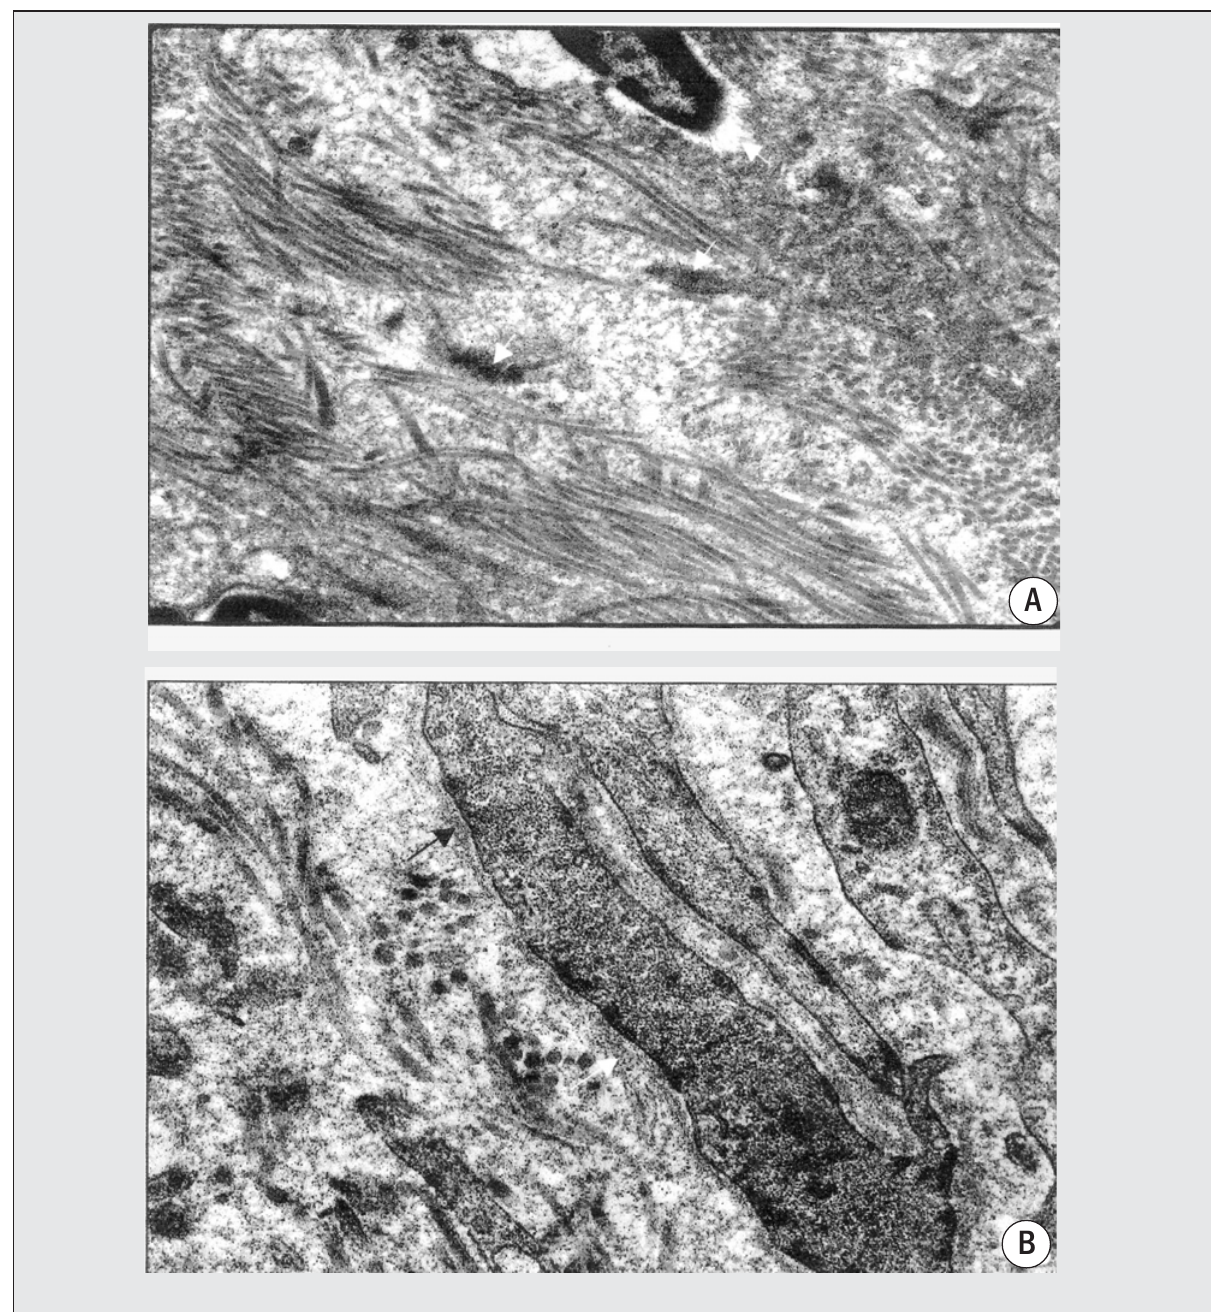
Figure 3 – A – Group II, 2 weeks after treatment. Area of densely packed collagen fibrils showing at the center a clear zone of rarefaction and focal electron-dense granular material (arrow heads). At the top, part of a connective tissue cell exhibiting around it a clear halo of stromal lysis. Electron micrograph, x 7,000; B – Group I, 2 weeks after treatment. Area of fragmentation of collagen fibrils in the presence of myofibroblasts, which exhibit sub-membranar stress fibers and peri-cellular non-fibrilar collagen (arrows). Electron micrograph, x